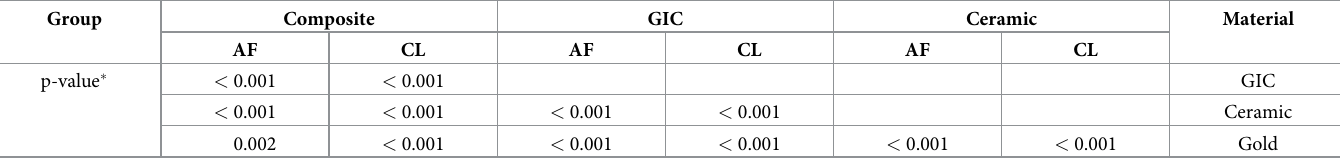
Table 6. Intragroup comparison of p-values between the median Ra of used restoration materials � .